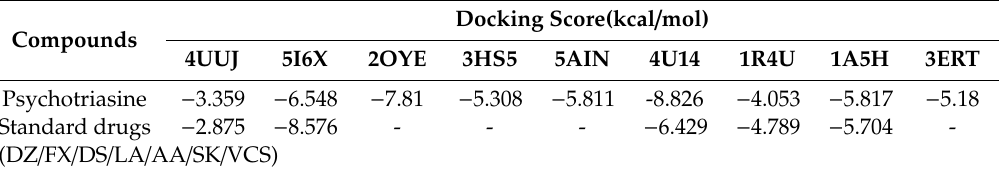
Table 5. Table 4. Docking score of the psychotriasine isolated from the P. calocarpa .